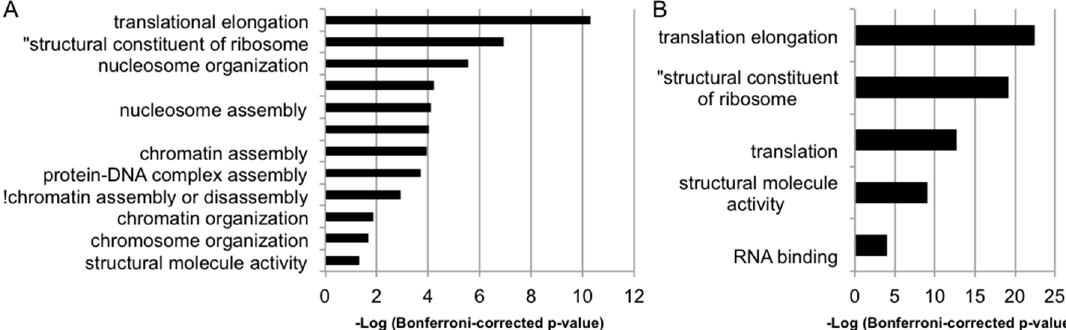
Figure 3. Gene Ontology (GO) enrichment analysis on all differentially expressed genes due to overexpression of MSNP1AS . GO enrichment analysis was performed on ( A ) SK ‐ N ‐ SH cells after 72 h, and ( B ) ReNcell CX cells after 24 h.